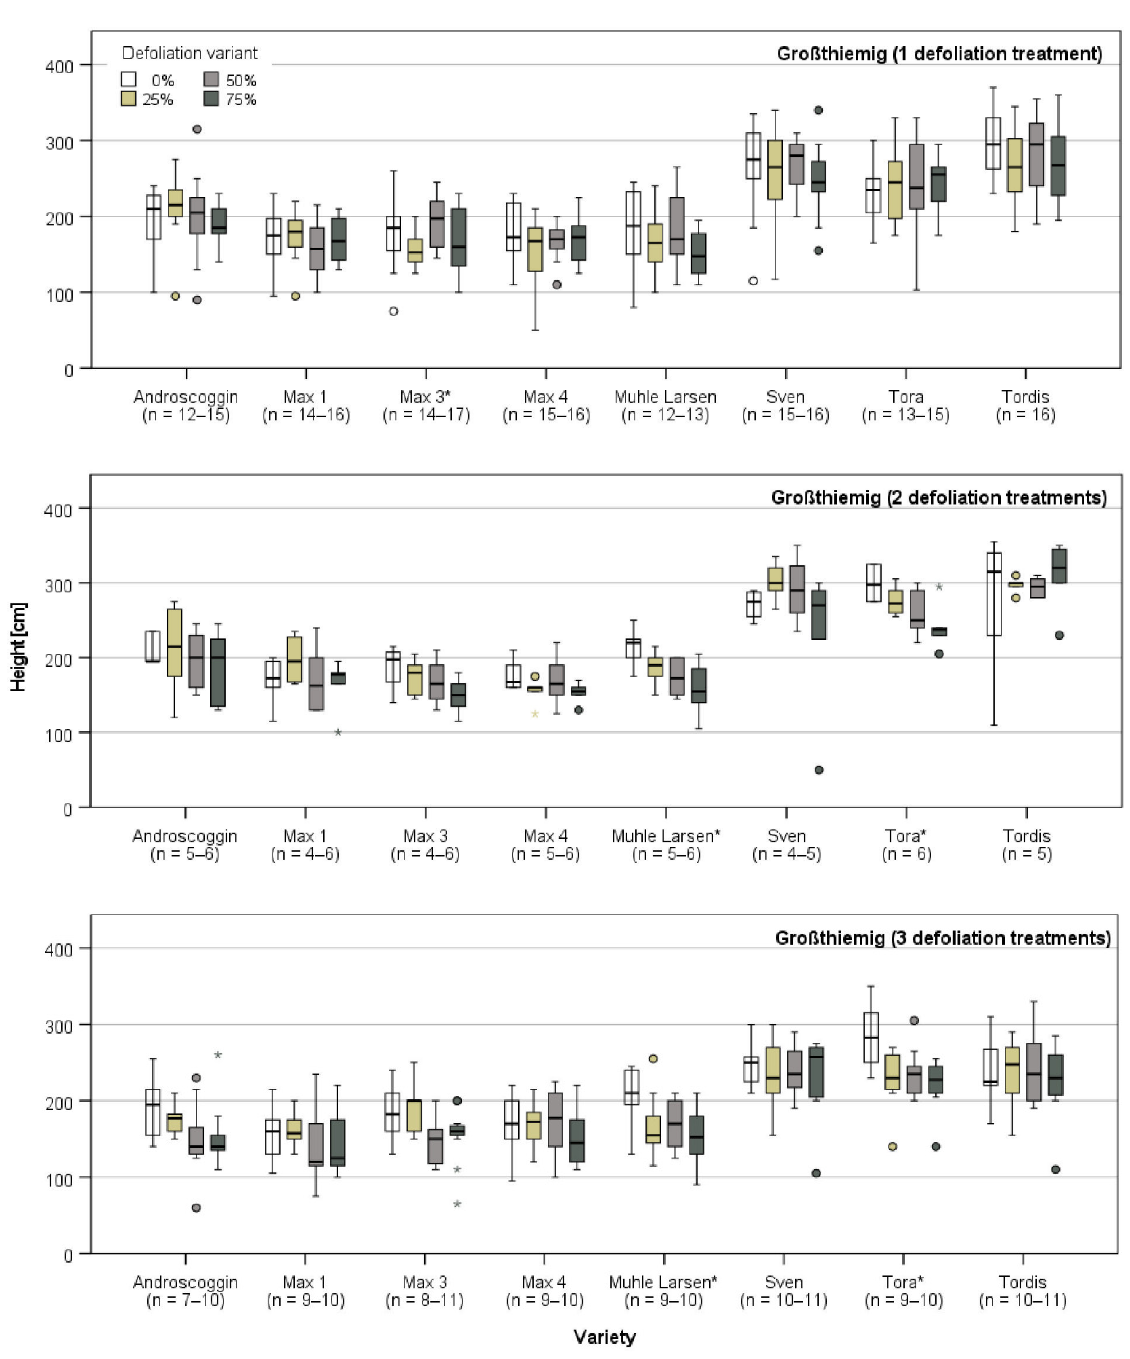
Figure 2. Height of poplar and willow varieties on the study site in Großthiemig with regard to the number of defoliation treatments prior to the start of the growing season in 2009 (n = range of number of plants per defoliation variant, * statistically significant difference according to ANOVA).